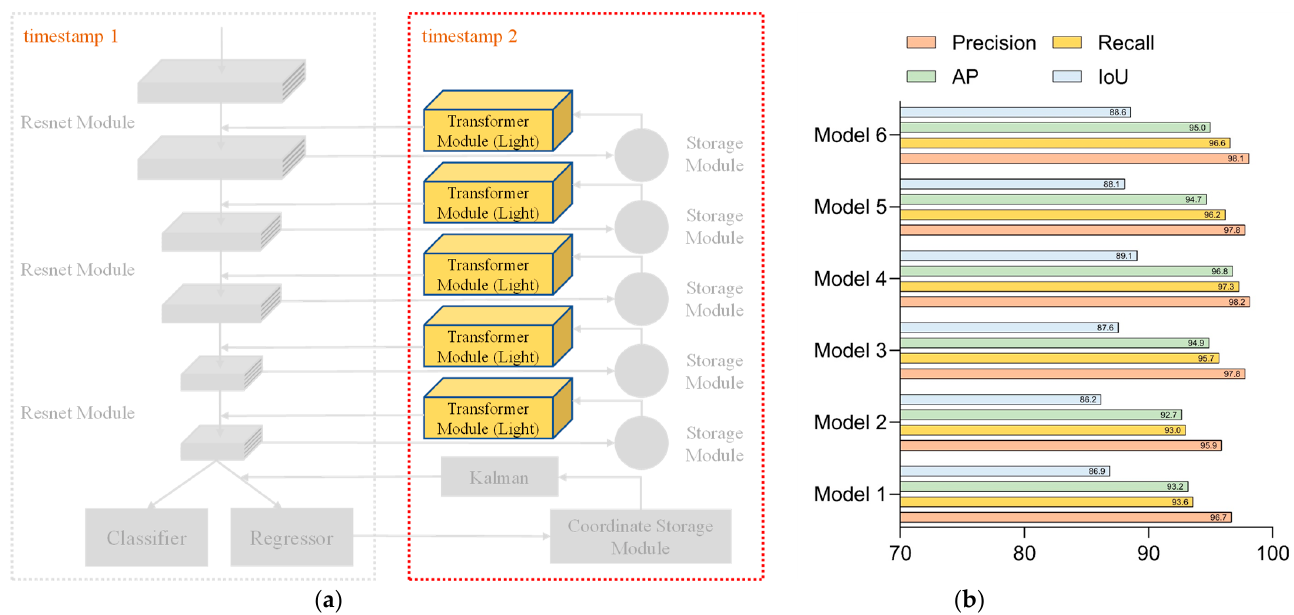
Figure 13. Network 6: ( a ) configuration of Network 6 and ( b ) test results for each parameter of Network 6.